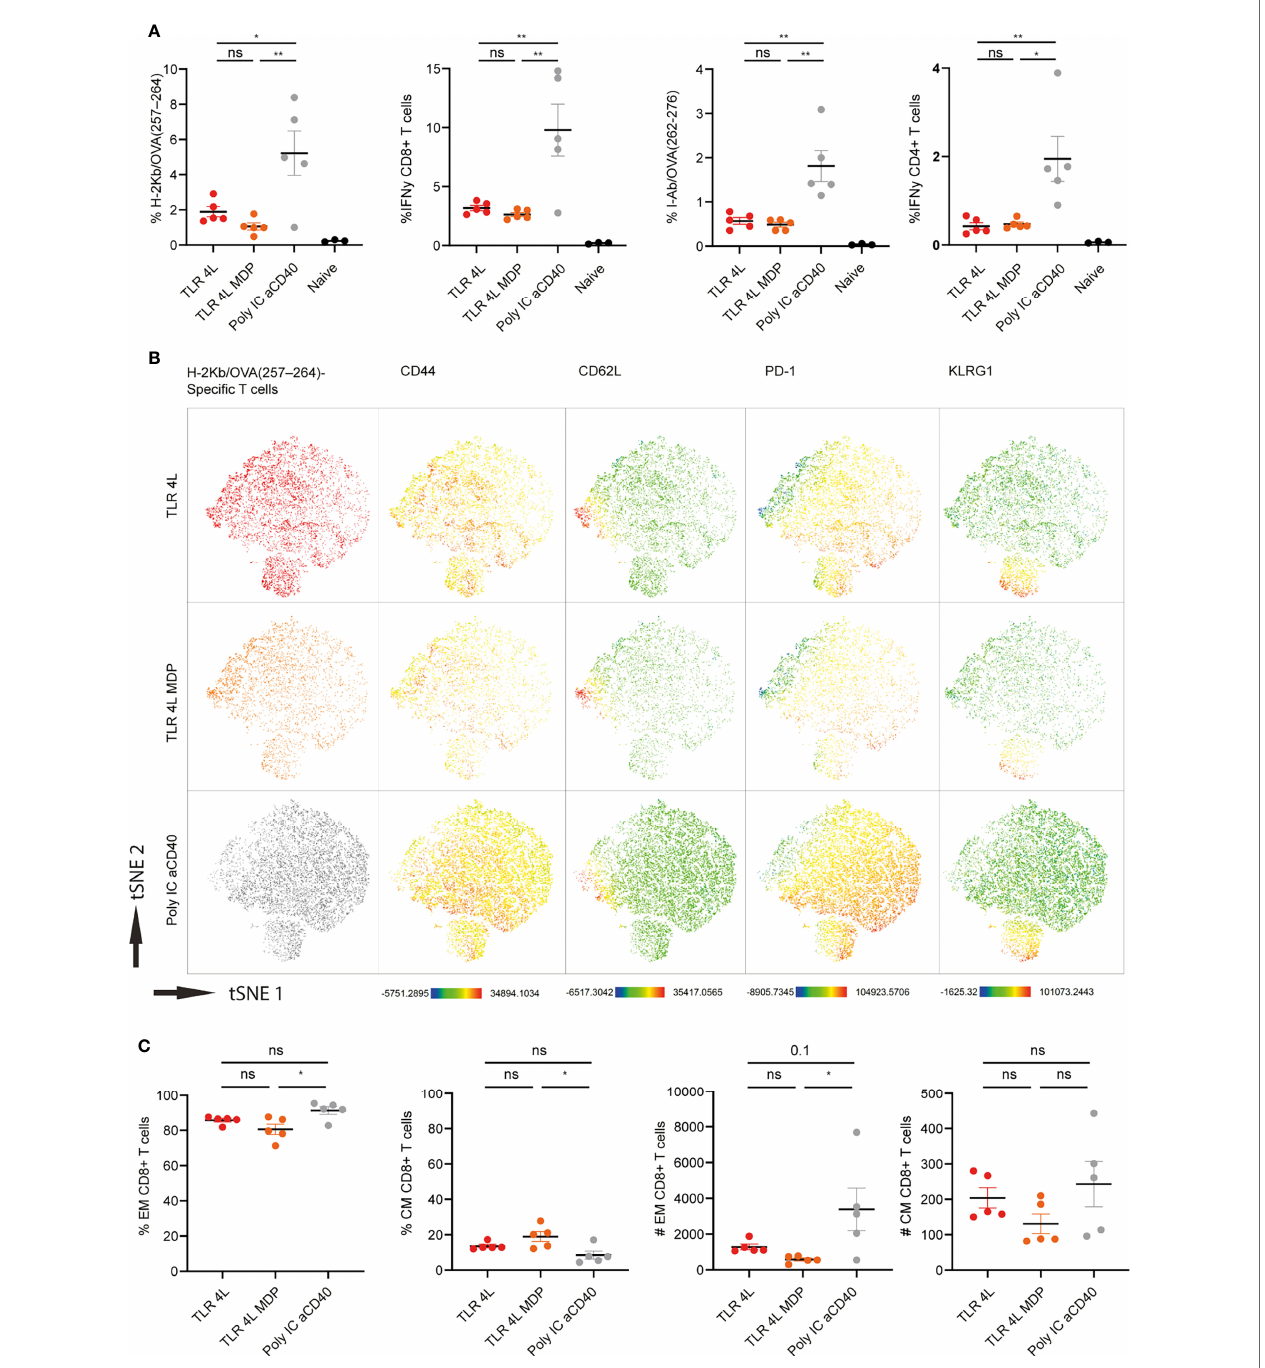
FIGURE 6 | Addition of MDP does not augment the potency of TLR4L-containing GM3 liposomes. (A) Mice were i.v. injected with different liposome formulations, or antigen-containing liposomes with poly IC and aCD40 antibody as soluble adjuvant as a positive control, or left uninjected (naive). 7 days after injection, spleens were collected and a single cell suspension was used for tetramer staining or peptide restimulation. Indicated is the average ± SEM of the percentage of IFN g − producing CD8 + and CD4 + T cells upon peptide restimulation and CD8 + and CD4 + tetramer binding cells ( n = 3-5). (B) H-2Kb/OVA 257-264 binding T cells as identi fi ed in A were clustered using high-dimensional data reduction. H-2Kb/OVA 257-264 binding T cells are indicated phenotyping (groups were indicated with different colors in the fi rst column) as well as their expression levels of CD44, CD62L, PD-1 and KLRG1. (C) H-2Kb/OVA 257-264 binding T cells were subdivided in CD44 + Tem and CD44 + CD62L + Tcm cells. Indicated is the average ± SEM of the percentage (of antigen-speci fi c CD8 + T cells) and number of cells identi fi ed as Tem or Tcm (based on 10 6 events) ( n = 5). *p < 0.05 and **p <0.01. ns, not signi fi